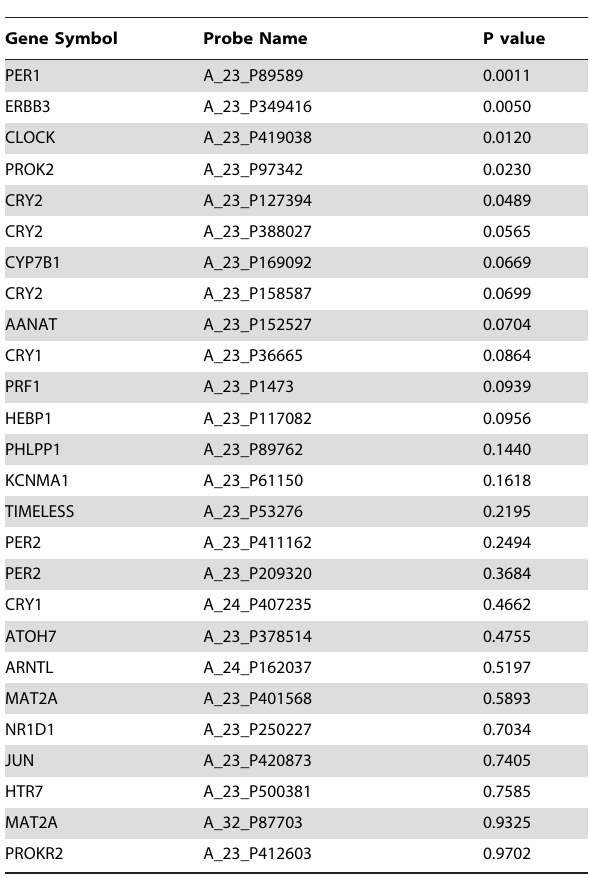
Table 3. Genes related to circadian rhythm.